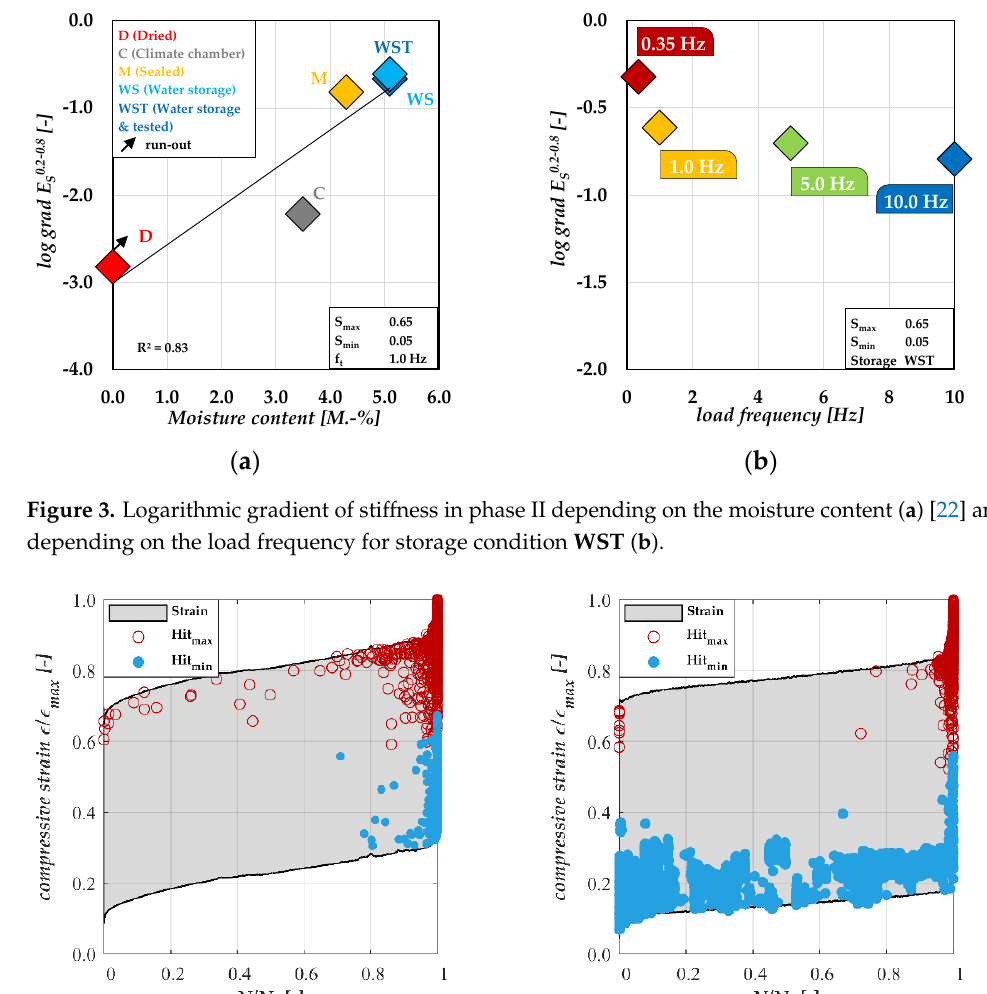
Figure 3. Logarithmic gradient of stiffness in phase II depending on the moisture content ( a ) [22] and depending on the load frequency for storage condition WST ( b ).